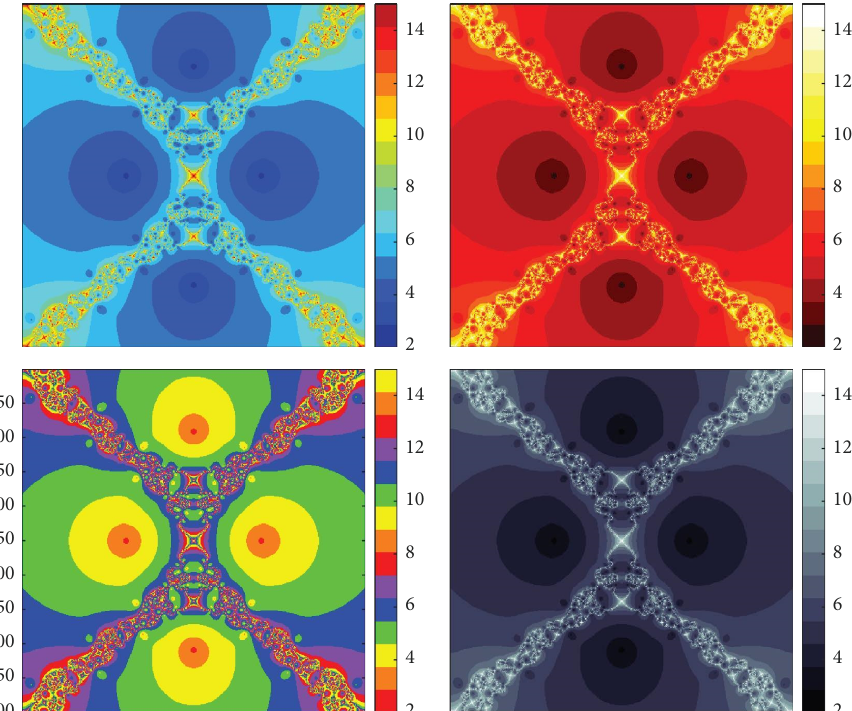
Figure 16: Examples of polynomiographs of diferent color maps for p